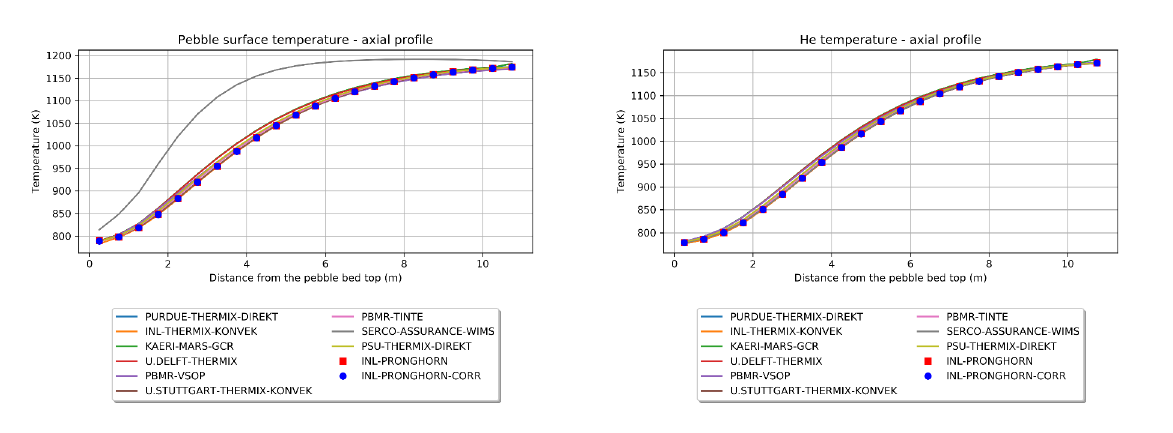
Figure 12: Pebble Surface Temperature - Axial Profile Comparison